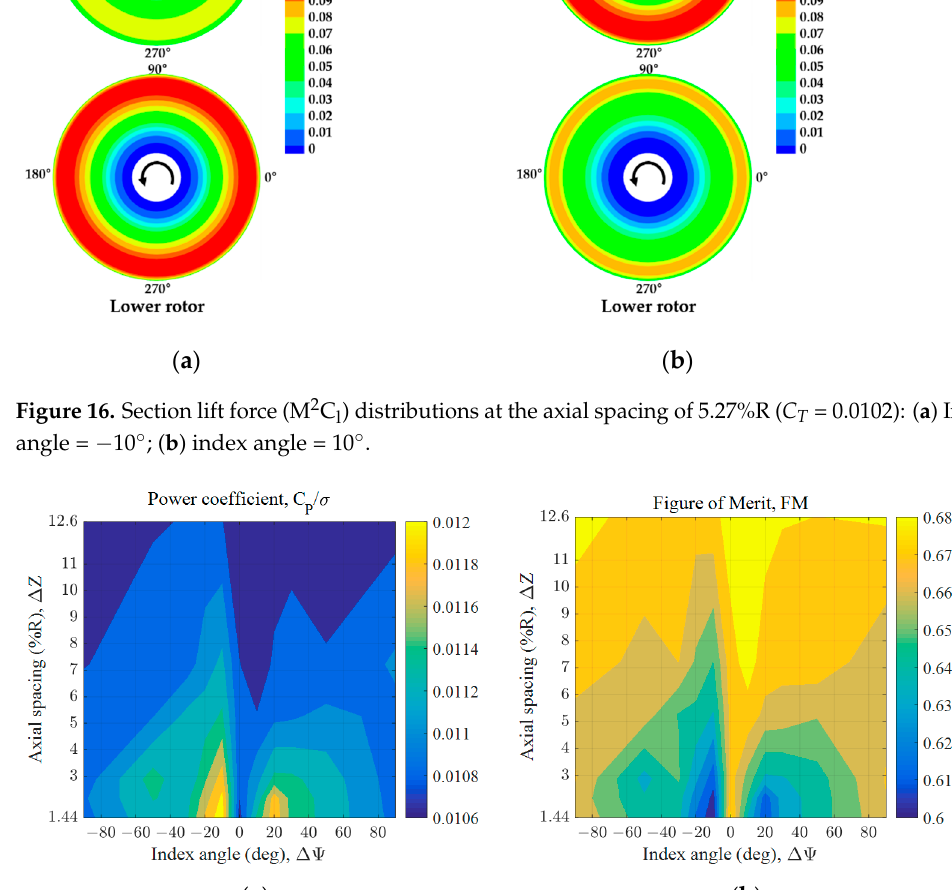
Figure 17. Hover performance analyses with respect to various index angles and axial spacings with blade taper ratio = 0.8 ( C = 0.0102): ( a ) Power ( C / σ ); ( b ) Figure of Merit (FM).